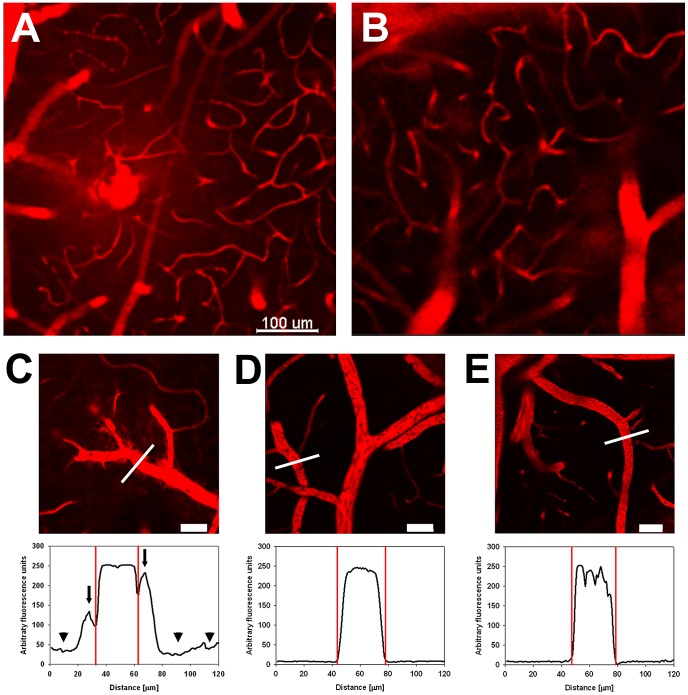
Site of the ECM-associated BBB opening within the cerebral vascular tree.CBA/CaJ mice were infected with PbA, PyXL, or no parasites. Microhemorrhages were occasionally found in the cortical vasculature of PbA-infected mice with ECM (A), but not PyXL-infected mice with HP (B). C–E, upper panels: C) PbA-infected mice exhibited extensive Evans blue leakage from PCV, but not capillaries, into the PVS and the parenchyma. In contrast, there was no Evans blue leakage into the cerebral parenchyma of PyXL (D) or age-matched uninfected control mice (E). C–E, lower panels: Graphic representation of Evans blue emission in relation to PCV from PbA, PyXL, and control mouse brains. The graphs show the Evans blue emission profile along the lines shown in (C–E). Note the emission peaks on either side of the PCV in the PbA-infected brain, which represent Evans blue leakage into the PVS (arrows). These peaks are absent in the PyXL-infected and control brain. Further, the overall Evans blue signal in the parenchyma surrounding the PCV is elevated in the PbA-infected brain (C, arrowheads) compared to the controls (D, E). The serrated shape of the control profile (E) is due to the presence of (dark) intravascular RBC. Scale bars = 100 µm (A, B), 50 µm (C–E).